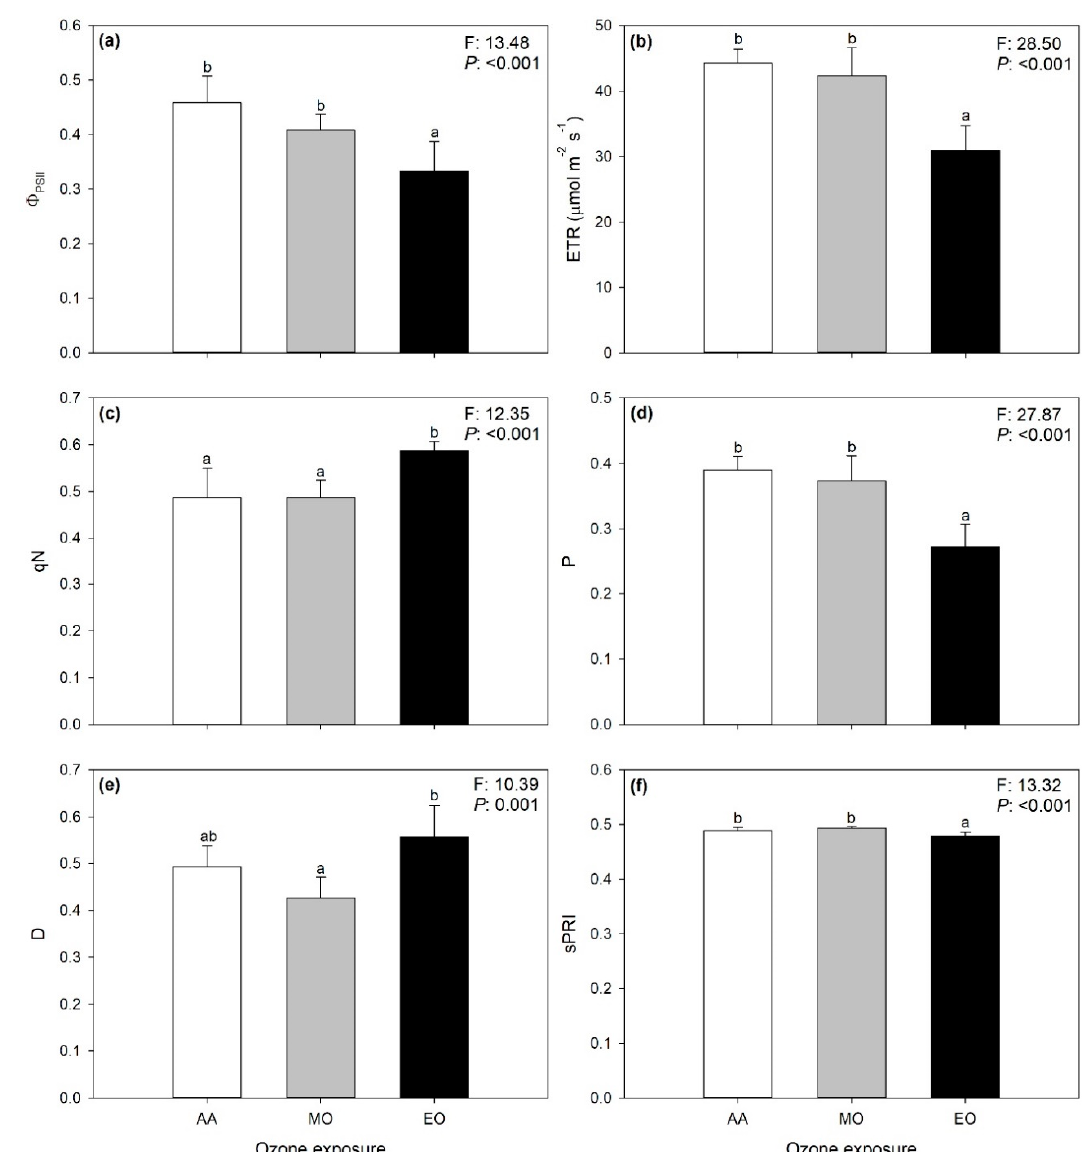
Figure 4. Variations of PSII operating efficiency in light conditions, Φ PSII ( a ); ETR, electron transport rate, ETR ( b ); non-photochemical quenching calculated as (F m − F m ’)/(F m − F 0 ′ ), qN ( c ); fraction of light absorbed in PSII antennae that is utilized in PSII photochemistry, P ( d ); fraction of light absorbed in PSII antennae that is dissipated thermally, D ( e ); and (scaled) photosynthetic reflectance index, sPRI ( f ) estimated from spectra collected on leaves of date palm under ambient (AA, white), moderate (MO, gray) and elevate (EO, black) ozone concentrations. Data are shown as mean ± standard deviation. F- and p -values for the effects of ozone from a one-way ANOVA are shown in the top-right corner of panels. According to Tukey’s post-hoc test, different letters indicate significant differences among means ( p : ≤ 0.05).